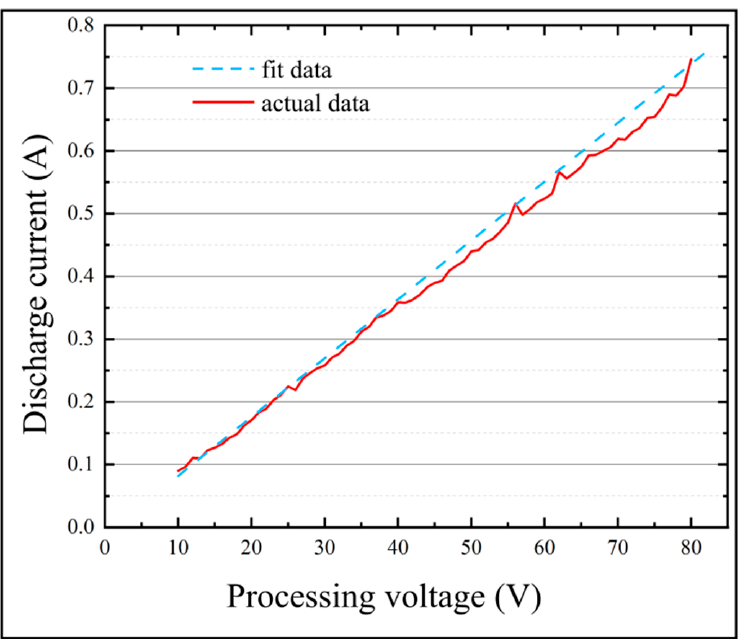
Figure 6. Results of correspondence between the discharge current and the machining voltage.